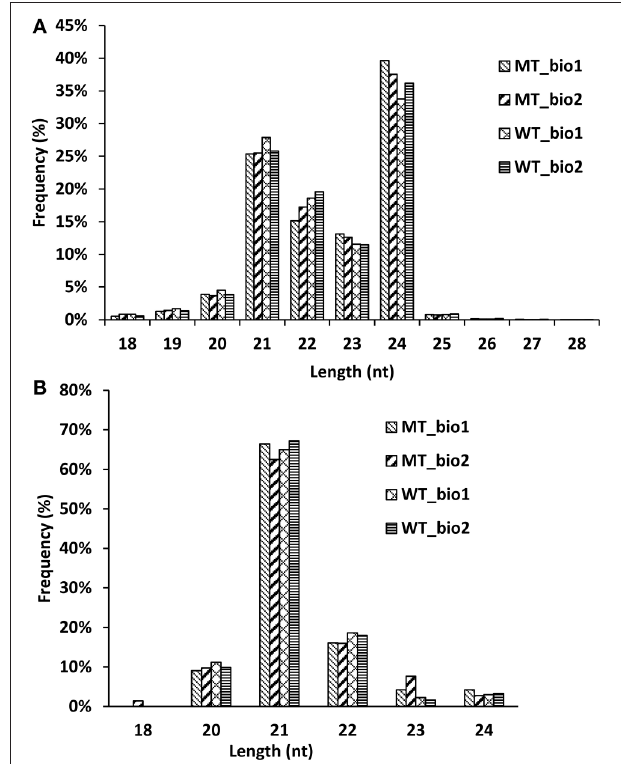
FIGURE 1 | Length distribution of the small RNA reads (A) and known miRNAs (B) in the sequencing